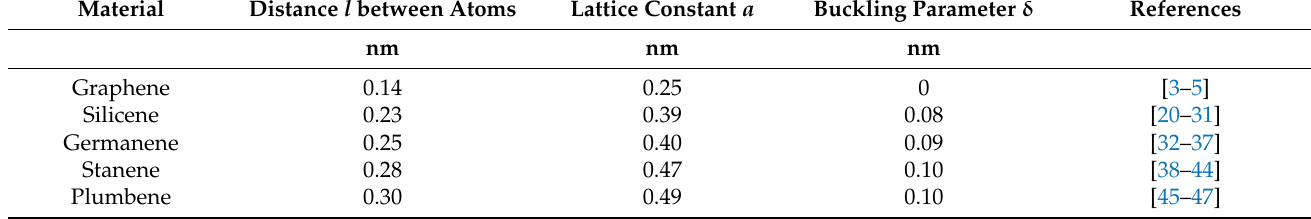
Table 1. Structural parameters of the buckled honeycomb lattice of graphene and group IVA transgraphenes. Material